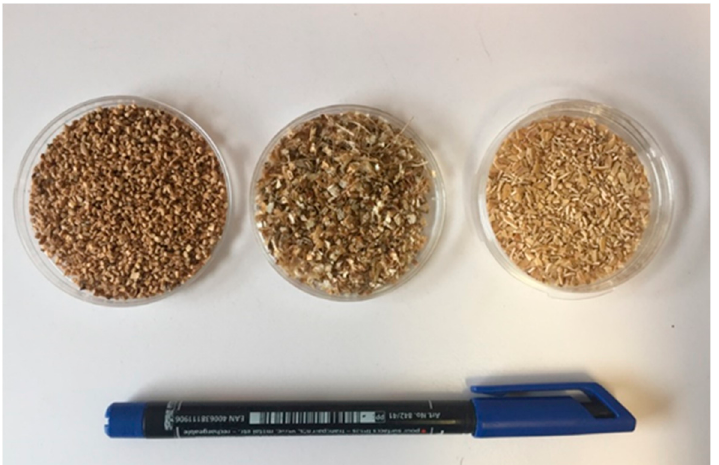
Figure 1. Sieved fraction (between 1 and 2 mm) of biosorbents (left to right: hazelnut, pistachio, walnut). To better assess variations within elements and biosorbents, differences ( ∆ )